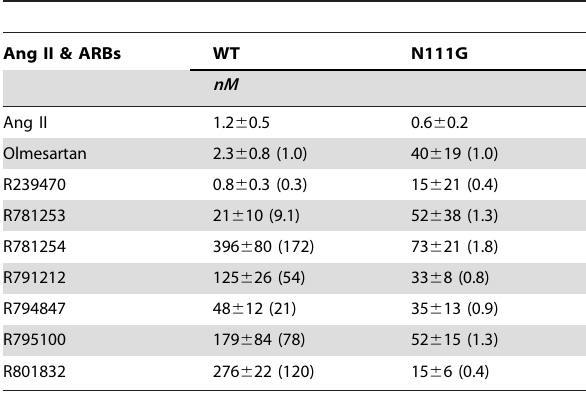
Figure 1. Construction of olmesartan-related compounds. doi:10.1371/journal.pone.0037974.g001 group instead of a carboxyl group in olmesartan with a phenyl group, also exhibited a 8.1-fold reduction in affinity in the Y113F mutant, and a . 10-fold reduction in affinity in the A106G (17-fold reduction), V108A (51-fold reduction), Y113A (38-fold reduction) Table 1. Binding affinities ( K d ) of Ang II and R compounds to AT 1 wild-type (WT) and mutant